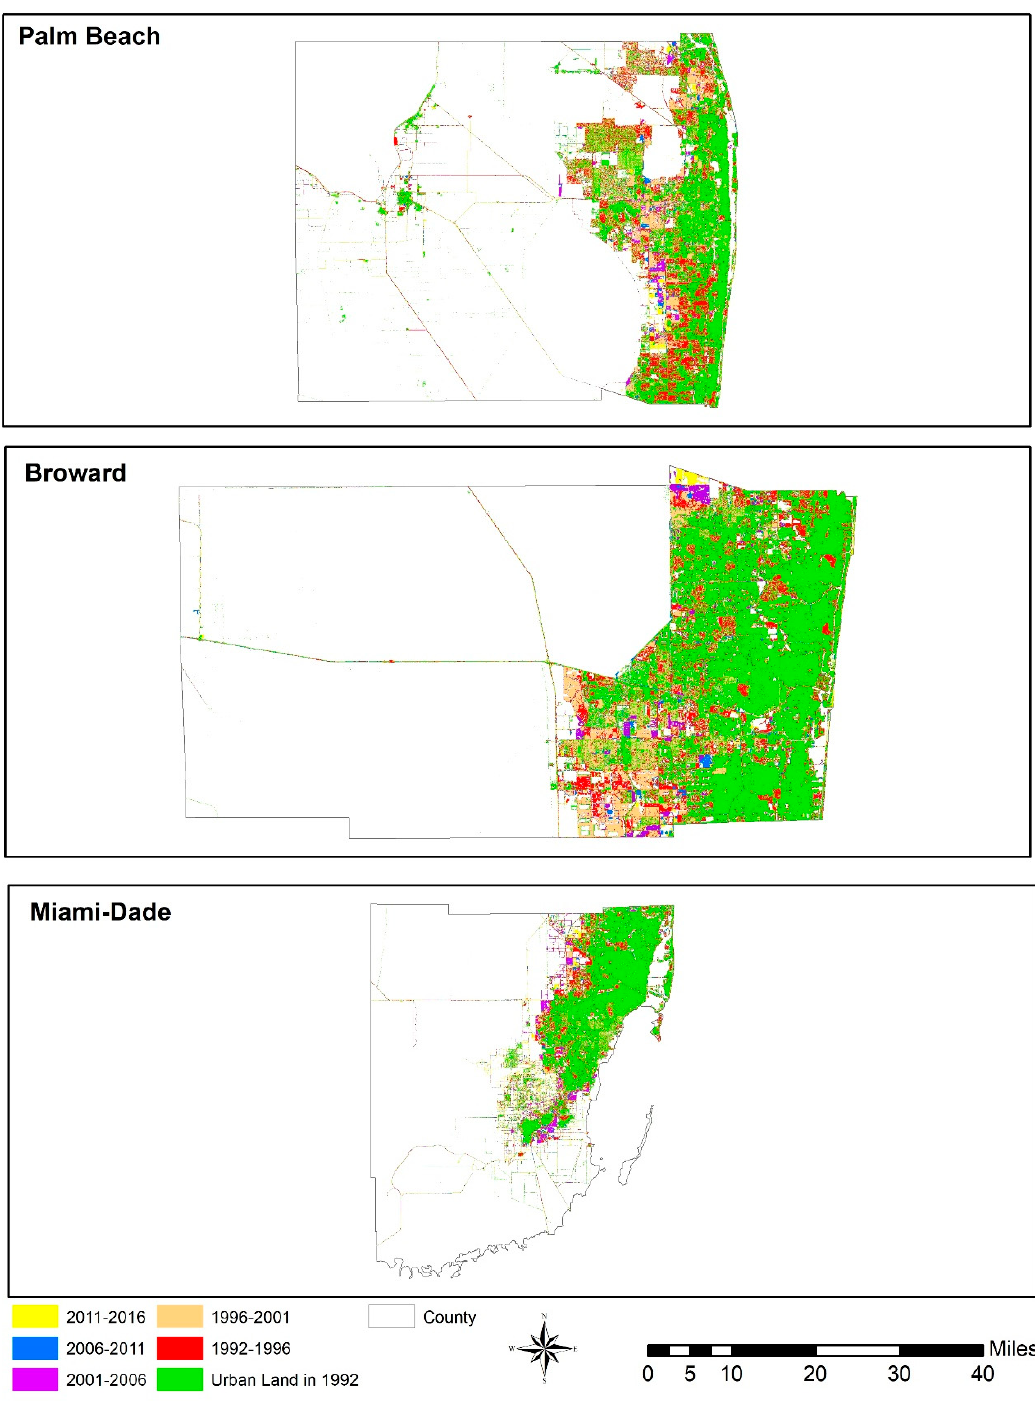
Figure 11. Urban expansion over different time periods in the tri-county region.